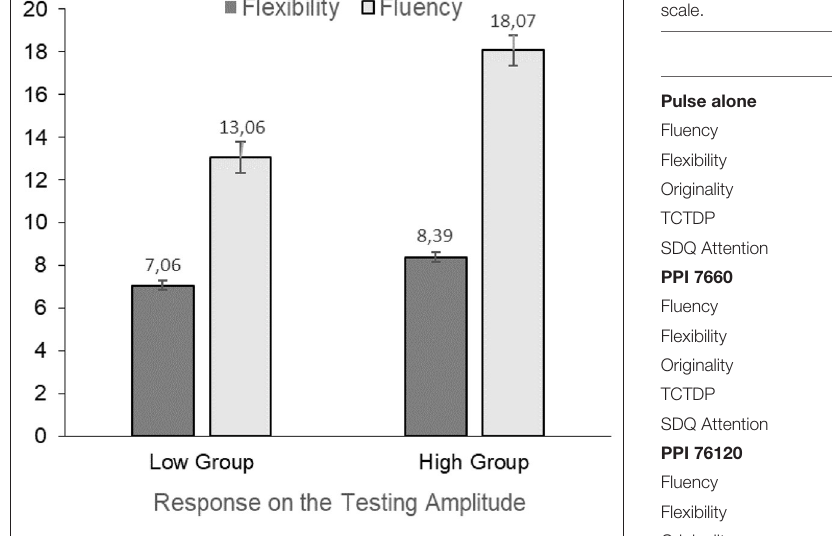
FIGURE 1 | Significant difference in mathematical creativity components fluency and flexibility between the group with higher testing amplitudes and the group with lower amplitudes in the P50 suppression paradigm. The estimated marginal means and standard error of the groups displayed in the figure are corrected for intelligence.